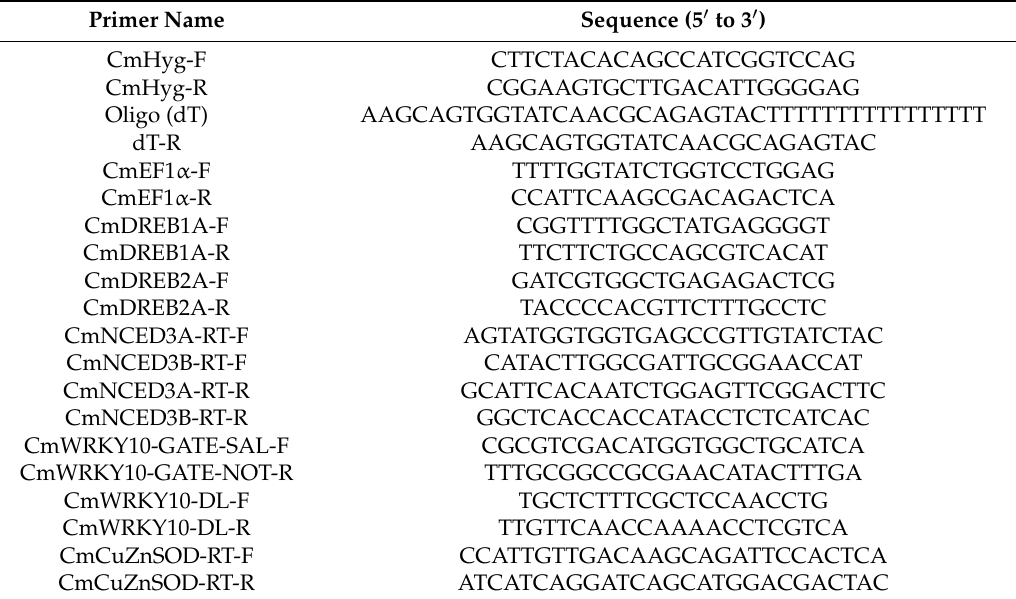
Table 1. The primer names and sequences used in this